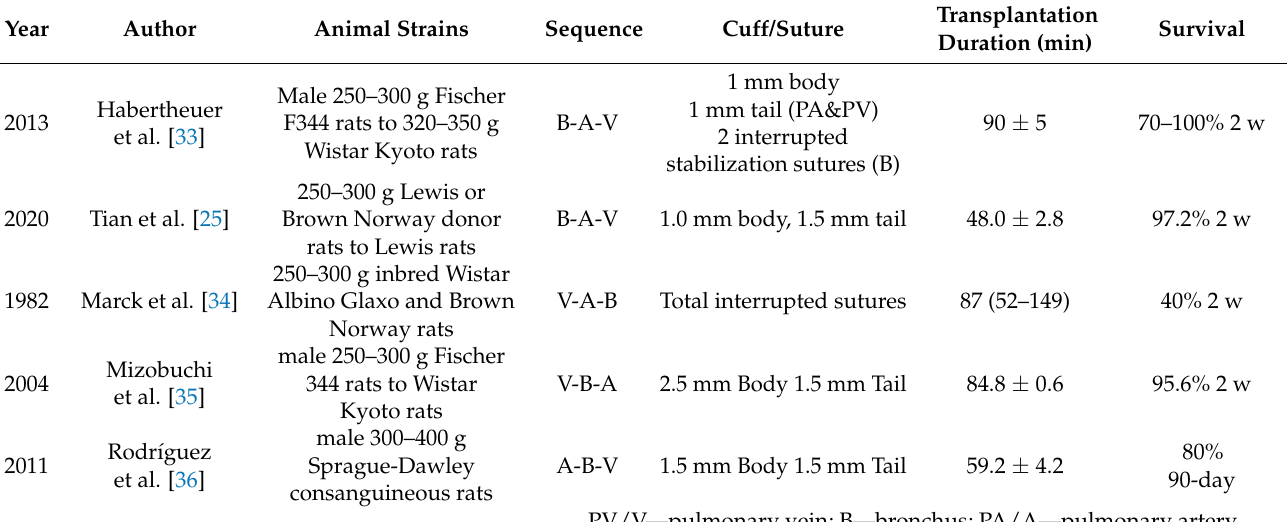
Table 2. Comparison of anastomosis order and major